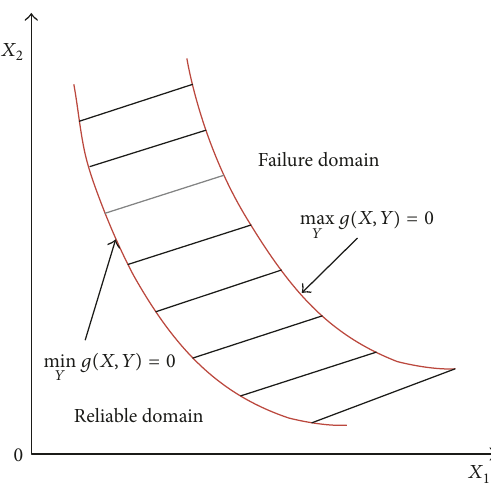
Figure 1: The region of extreme postural